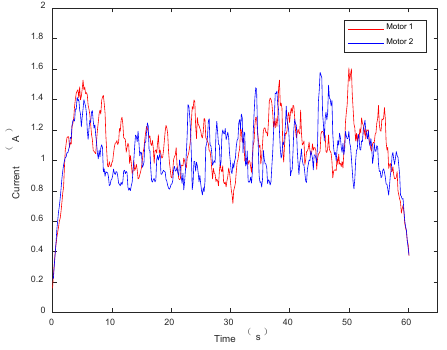
Figure 21. Current of motors.